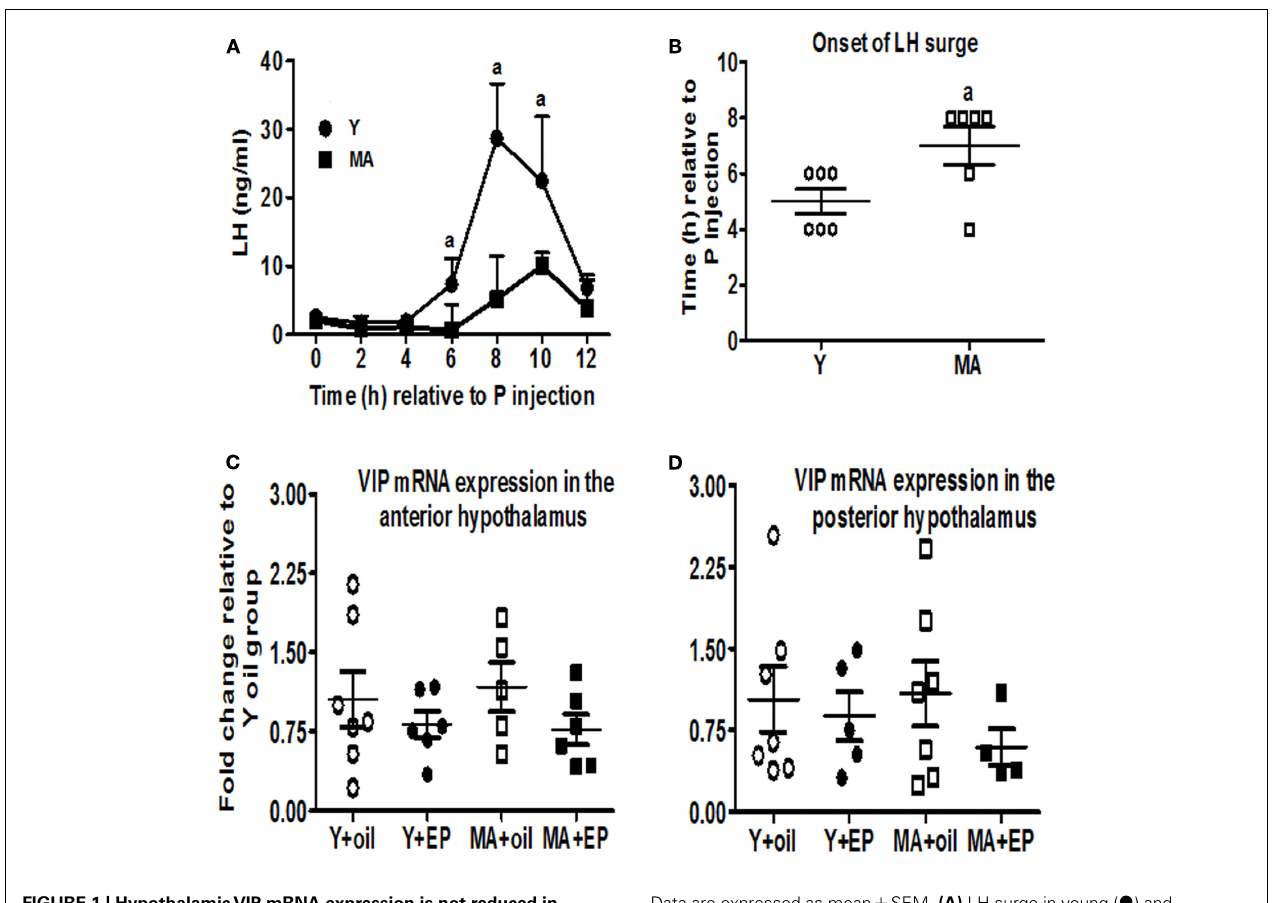
FIGURE 1 | HypothalamicVIP mRNA expression is not reduced in regularly cycling, middle-aged females with delayed and attenuated LH surges. OVX young (Y; n = 6) and middle-aged (MA; n = 6) female rats received two daily doses of E2 benzoate (E: 2 μ g) and one injection of progesterone (P: 500 μ g) on the day of serum collection, or vehicle (oil). Serial blood sampling started at the time of P injection and continued every 2h for 12h.Time 0 represents the time of the P injection. Separate rats were used in RT-PCR experiments and were killed 52h after the first injection of oil or E.